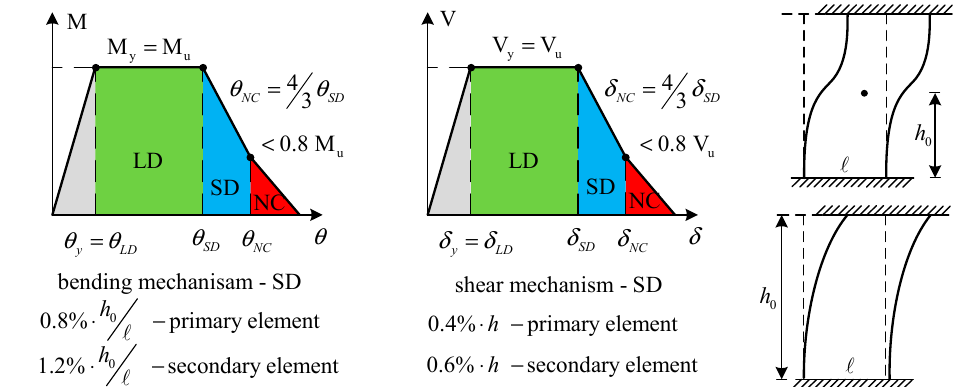
Figure 8. Typical force–deformation relation for masonry elements.